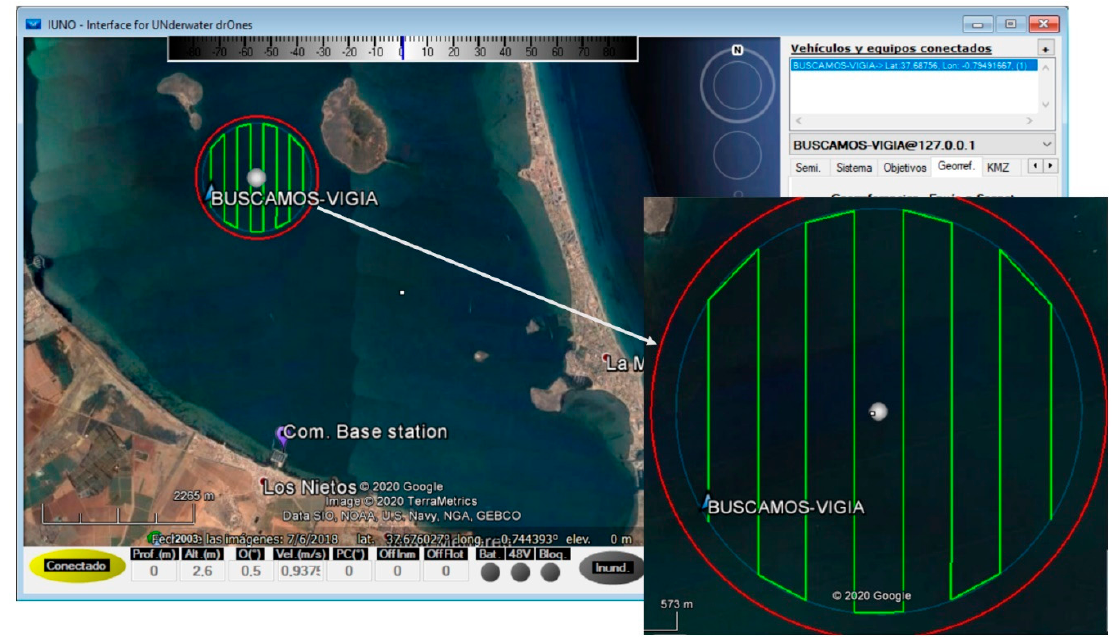
Figure 16. Start of mission (MMM) of surveillance of area equivalent to integral reserve.